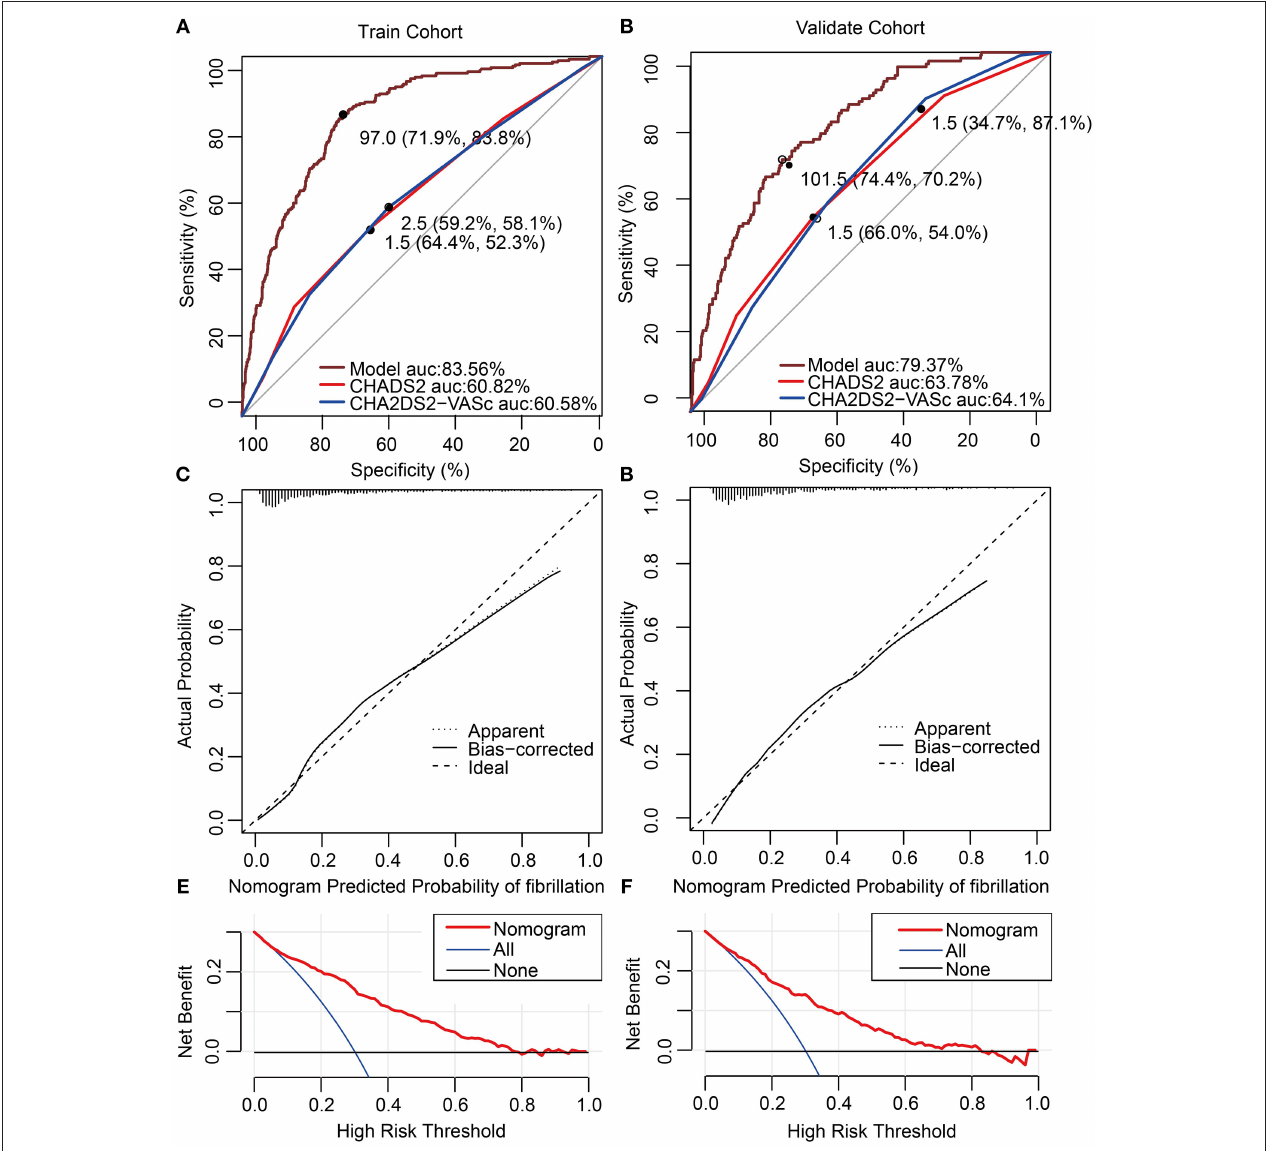
FIGURE 2 | (A,B) Receiver operating characteristic curve for models in predicting LAT/SEC in the training cohort and validation cohort. (C) Calibration curves for the nomogram in the training cohort. The dotted line represents the entire cohort ( n = 1,239), and the solid line is the result after bias-correction by bootstrapping (1,000 repetitions), indicating nomogram performance (boot mean absolute error = 0.027). (D) Calibration curves for the nomogram in the validation cohort. The dotted line represents the entire cohort ( n = 574), and the solid line is the result after bias-correction by bootstrapping (1,000 repetitions), indicating nomogram performance (boot mean absolute error = 0.020). (E,F) Decision curve analysis for the nomogram in the training cohort and validation cohort. The decision curve of the nomogram is composed of an X -axis which represents continuum of potential thresholds for LAT/SEC risk and a Y -axis which represents the net benefit which is obtained by dividing the net true positives by the sample size. The “All” curve shows the net benefit if all patients subject to transesophageal echocardiography (TEE). The “None” line shows the net benefit if no patient subject to TEE. The “Nomogram” curve shows the net benefit if it is used to select patients for TEE. For example, if the